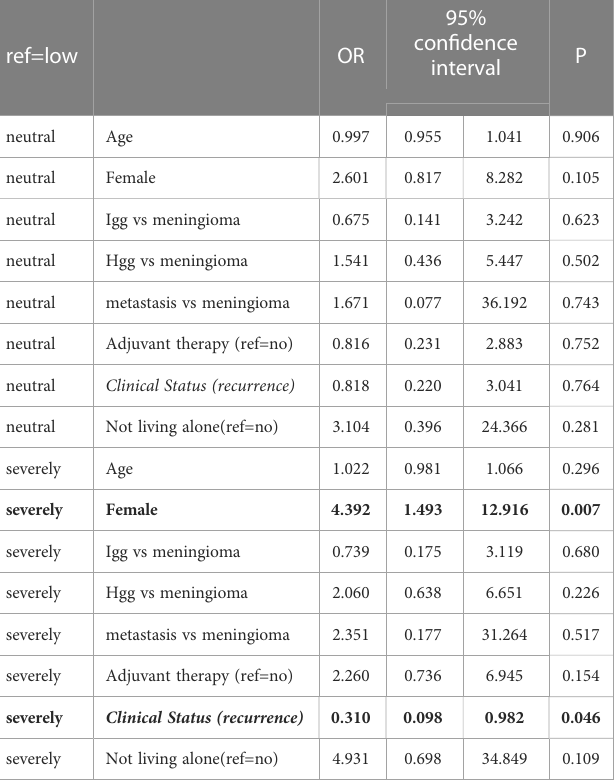
TABLE 5 – Variables associated with Worry about COVID-19- Results of multinomial regression analysis.